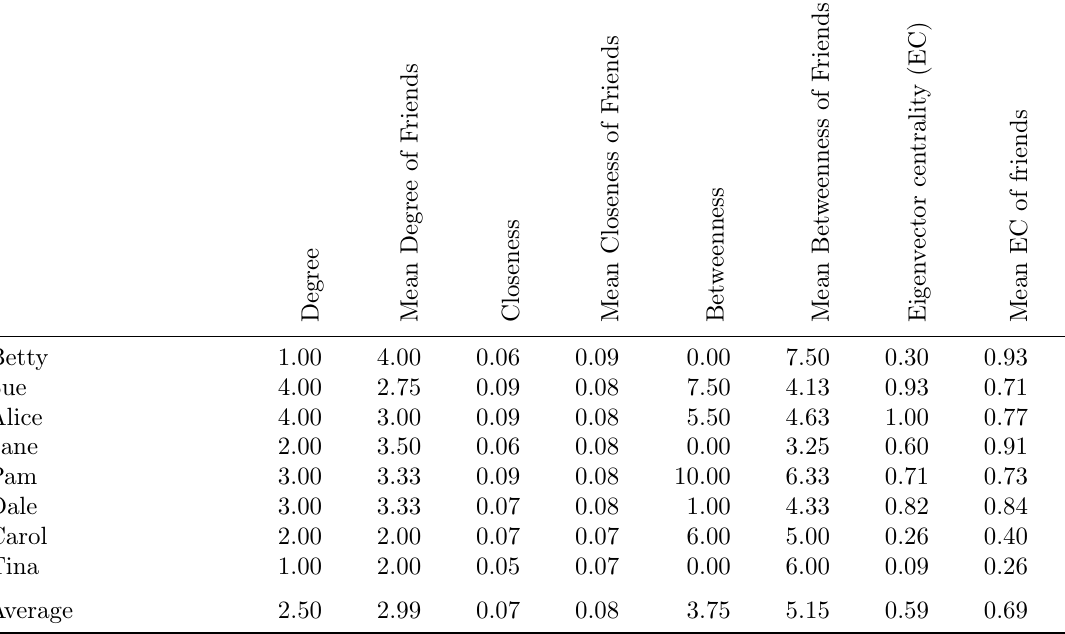
Table 1: Summary of individual’s network characteristics and mean network characteristics of